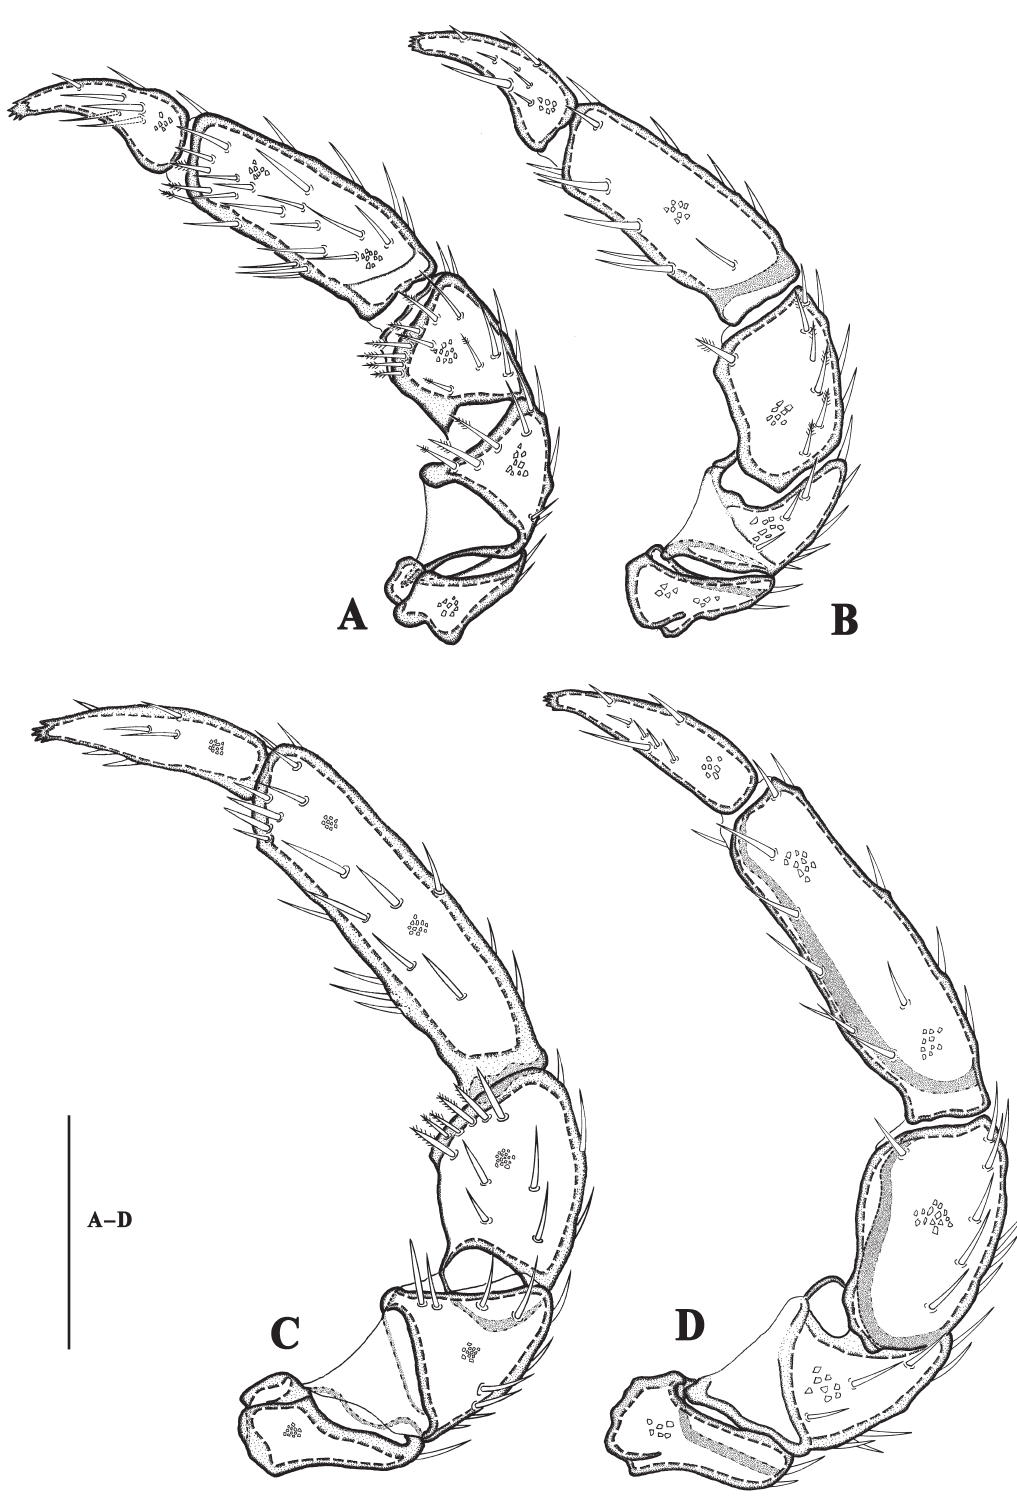
Fig. 3. Eylais ( Meteylais ) hamata Koenike, 1897. A–B . ♀ (GUGC QH-EY-20200804). C–D . ♂ (GUGC QH-EY-20200801). A . Palp, inner side. B . Palp, outer side. C . Palp, inner side. D . Palp, outer side. Scale bar = 200